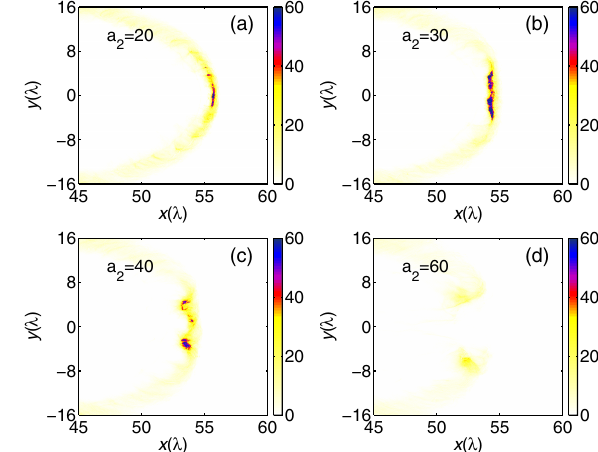
FIG. 6. The spatial density (normalized by n c ) distributions of the proton with different intensities of the auxiliary laser. The normalized amplitude of the auxiliary laser a 2 ¼ 20 in (a), a 2 ¼ 30 in (b), a 40 in (c), and a 60 in (d). These snapshots are 2 ¼ 2 ¼ corresponding to the moment t ¼ 42 T L